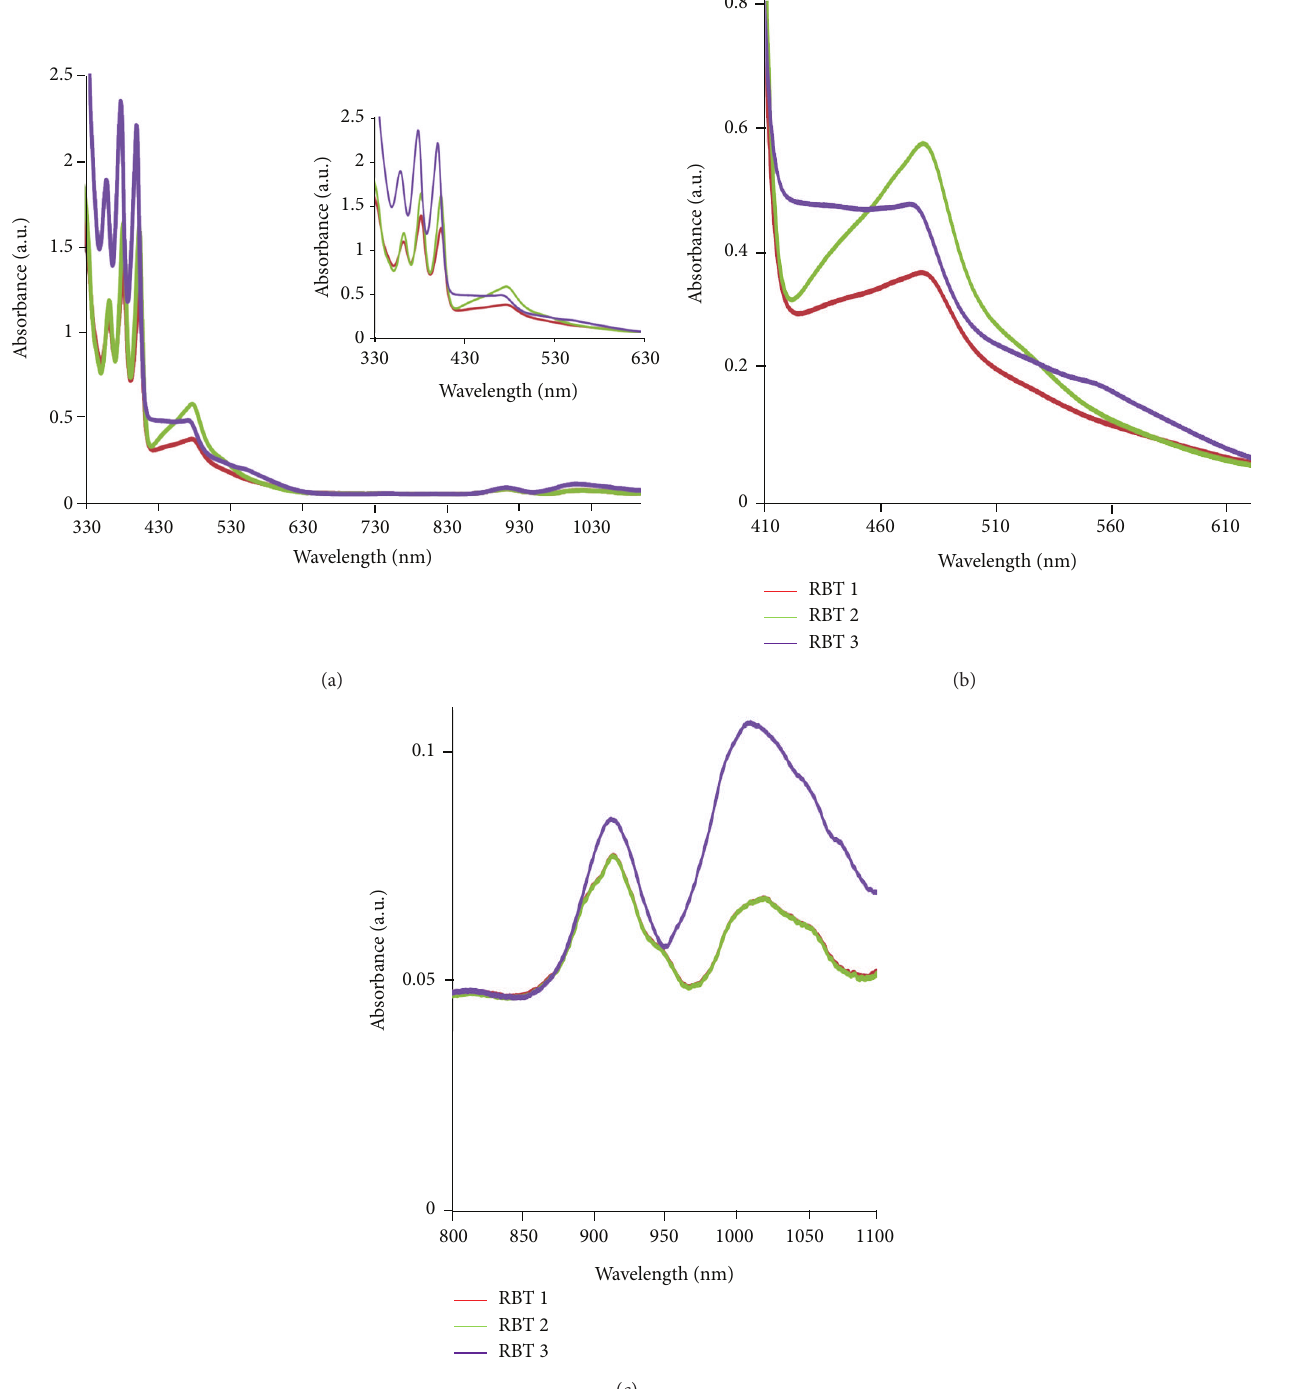
Figure 1: UV-Vis absorption spectra of the ( RBT1 , RBT2 , and RBT3 ) complexes at a concentration of 0.001 g/dm −3 in (CH 3 Cl/MeOH, 1:1,